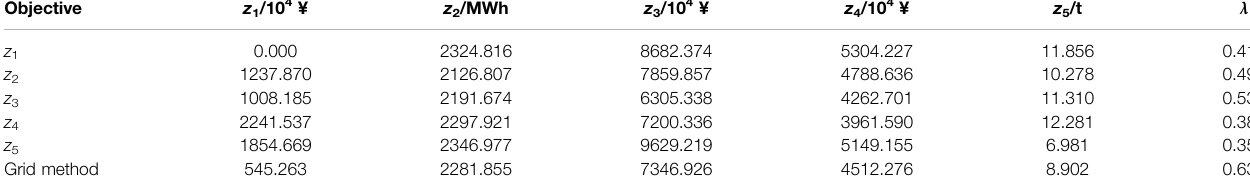
TABLE 7 | Comparison of the single-objective solutions and the COS. Objective